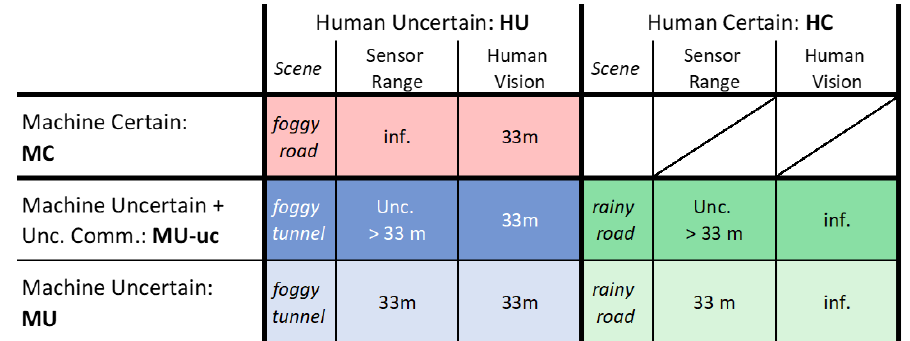
Figure 4. Overview of five experimental conditions with corresponding ranges for human vision and machine sensors. Colors are assigned to individual conditions to facilitate condition mapping of the results. For machine uncertain conditions (blue and green), the light colors mark conditions without uncertainty communication while their dark counterparts indicate uncertainty